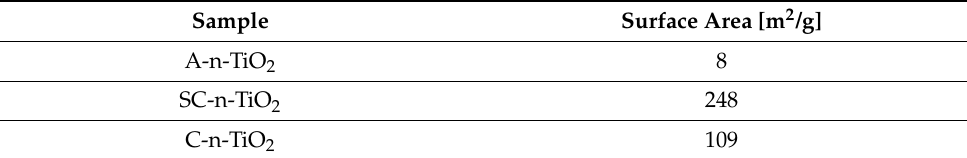
Table 1. The surface area of obtained n-TiO 2